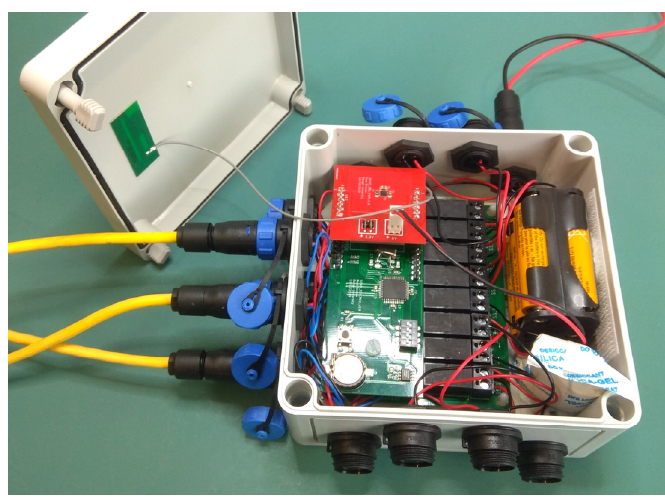
Figure 8. Complete IoT soil sensor node ready for testing.